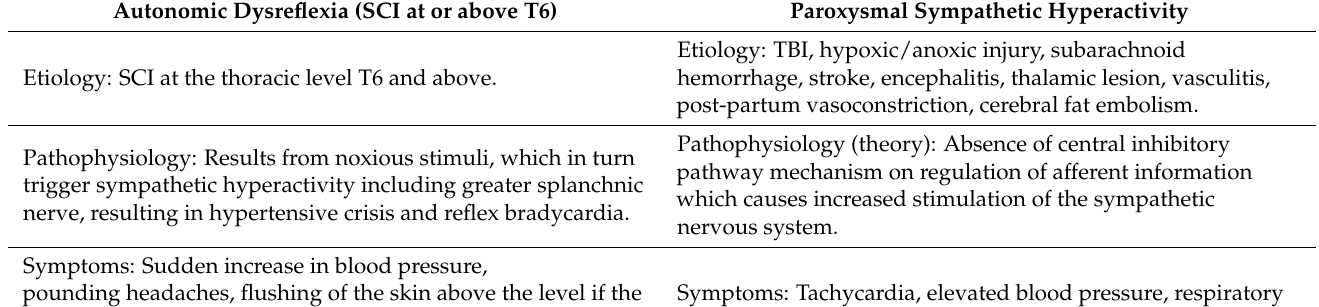
Table 1. Autonomic dysreflexia and paroxysmal sympathetic hyperactivity (storming). Autonomic Dysreflexia (SCI at or above